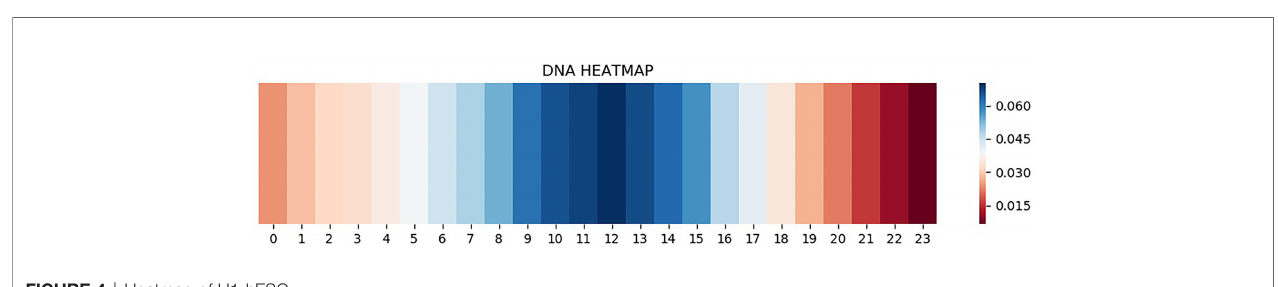
FIGURE 4 | Heatmap of H1-hESC.